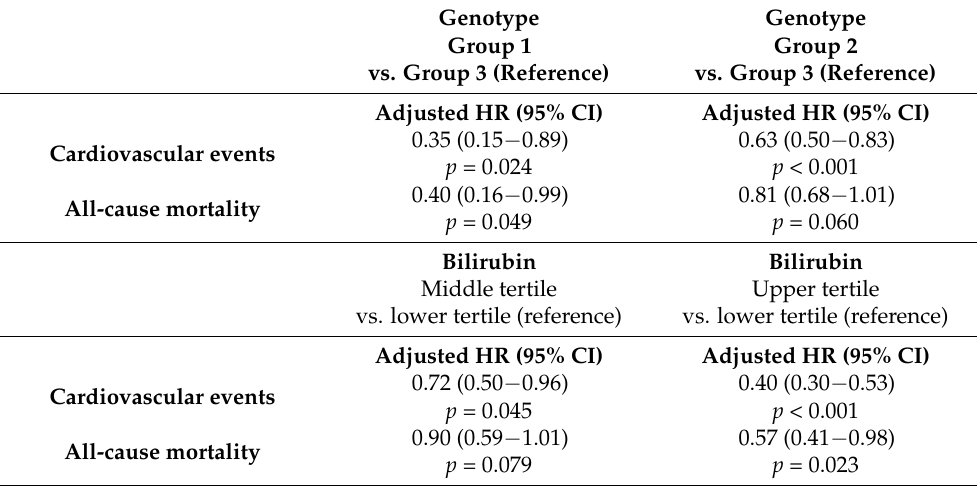
Table 2. Adjusted hazard ratio (95% confidence interval) of tertiles of bilirubin and various combina- tions of promotor polymorphisms of the HO-1 and UGT1A1 genes in chronic hemodialysis